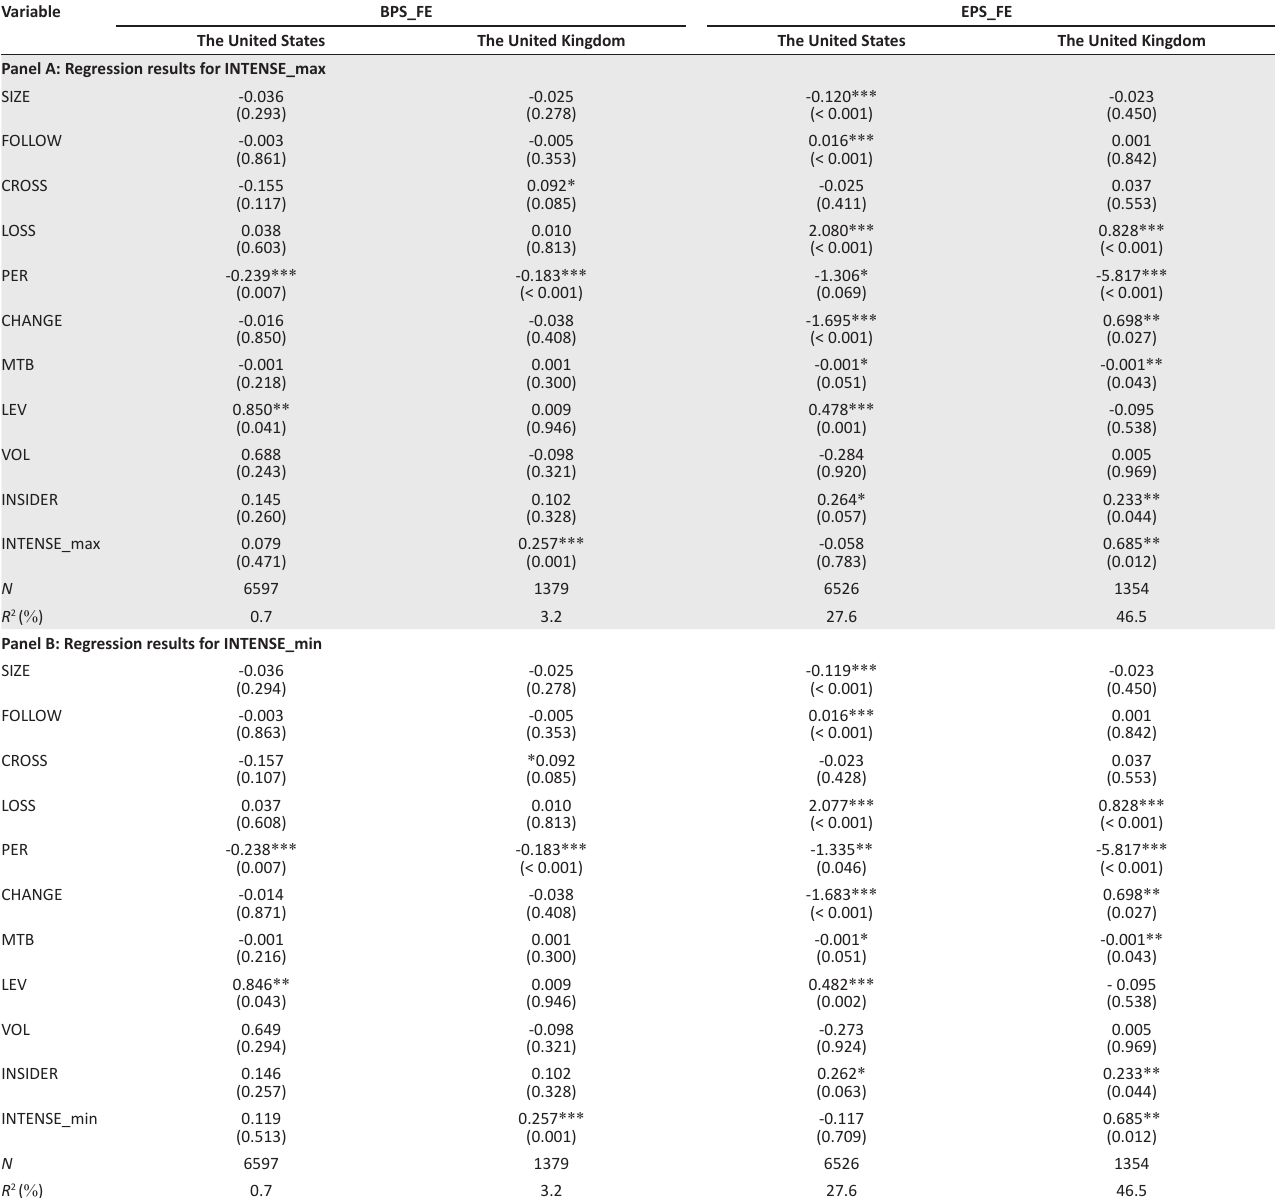
TABLE 3: Main regression results.